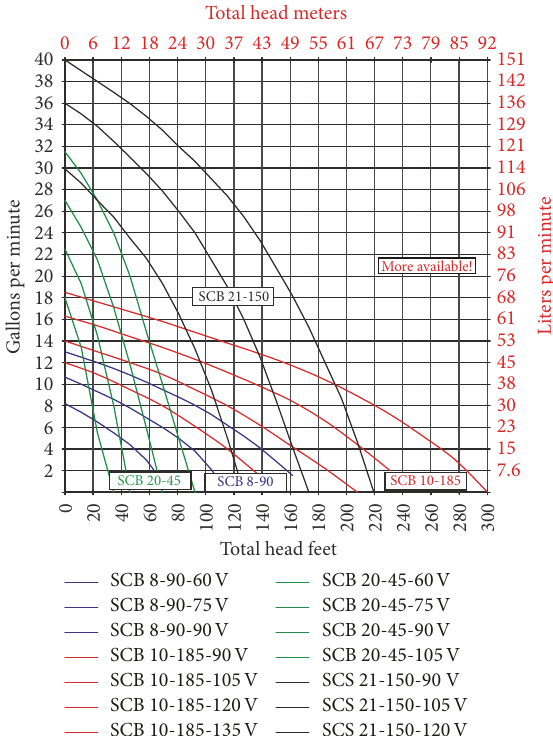
Figure 1: Centrifugal booster pump selection guide.